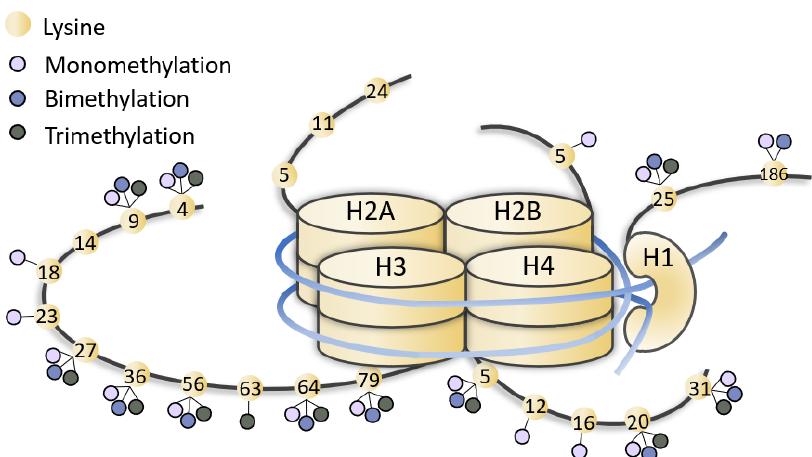
Figure 1. Representation of methylated lysines of histone tails. Lysines (yellow dots) of histone (H1, H2, H3, H4) tails can be mono-, bi-, tri-methylated (little lilac, blue and grey dots). The figure is not drawn to scale.